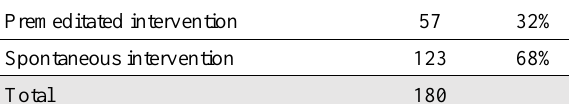
Table 9. Type of previous consideration of transformed buildings.